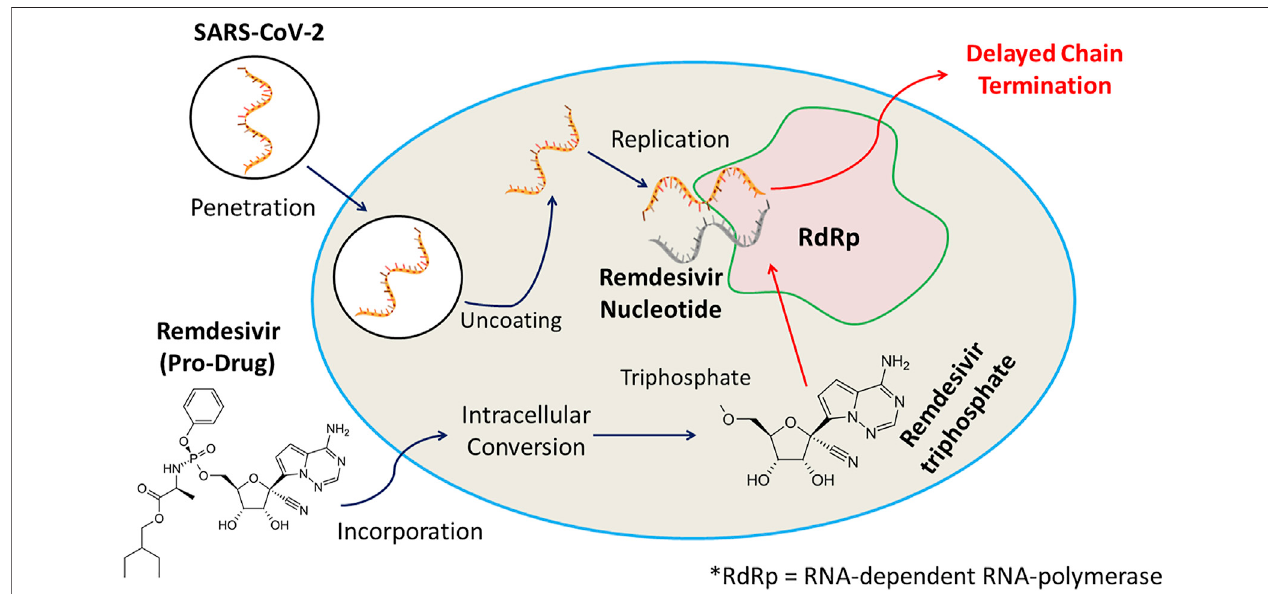
FIGURE 1 | Remdesivir, an investigational nucleotide analogue, and its triphosphate possessing resemblance with Adenosine triphosphate can compete with it to act as a substrate for various viral RNA polymerase inhibiting RNA synthesis. Remdesivir triphosphate form adds to the growing RNA chain more ef fi ciently than ATP, causing chain termination at 3 nucleotides downstream, and displays anti-COVID-19 ef fi cacy.